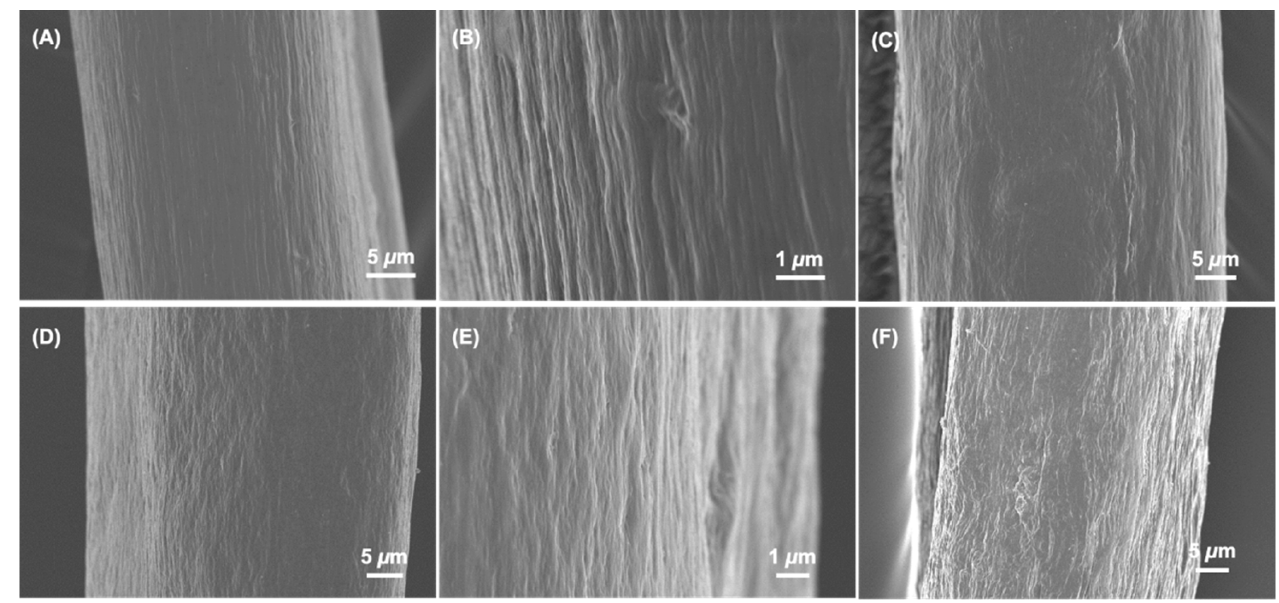
Figure 4. SEM of individual wet spun ( A , B , D , E ) and UV-cured ( C , F ) fibres prepared from either 4VBC-functionalised CRT ( A – C ) or GMA-functionalised CRT ( D – F ). ( A , B ): F-4VBC; ( C ): F-4VBC*. ( D , E ): F-GMA; ( F ): F-GMA*. Table 2. Characterisation of functionalised CRT fibres following either wet spinning or UV-curing. Data are presented as the mean ± SD. (a) PBS-equilibrated samples; n.a.: not available. Sample ID Ø/ µ m SR /wt.-% σ b /MPa ε b /% E /MPa F-C 80 ± 3 n.a. F-GMA 39 ± 10